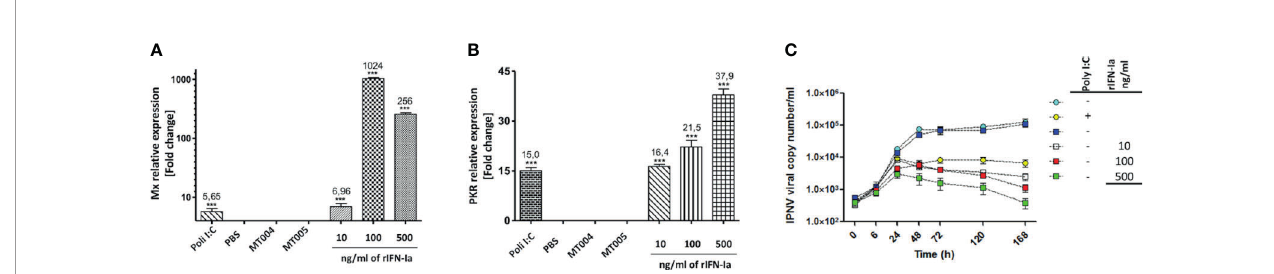
FIGURE 3 | Antiviral effect of cytoplasmic extracts containing rIFN-Ia. The fi gure shows the effect of 10, 100 and 500 ng/ml of rIFN-Ia on the gene expression of Mx (A) and PKR (B) in cultures of CHSE-214. The CHSE-214 cultures were exposed to a constant concentration of total protein which was achieved by mixing the MT006 extracts with the MT005 extracts. As a control, the extract of the L. lactis NZ3900 (MT005) and L. lactis NZ3900 (MT004) strains were used. The expression of Mx and PKR was evaluated by RT-qPCR and expressed as normalized change times with regard to the expression of 18S rRNA and with respect to the cultures exposed only to MT005. The effect of rIFN-Ia on the viral replication kinetic (C) was evaluated by qPCR on the culture media of SHK-1 cultures exposed to 10 h g/ml (open squares), 100 h g/ml (red squares), and 500 h g/ml (green squares) of rIFN-Ia, during the fi rst 168 h post infection with IPNV. The SHK-1 cultures were exposed to a constant concentration of bacterial protein which was achieved by mixing the MT006 and MT005 extracts. As control SHK-1 cells were exposed to extract of MT005 (blue squares), transfected with Poly I:C (yellow circles), or remains without treatment (light blue circles). The existence of statistically signi fi cant differences was determined using a one-way ANOVA analysis (***p